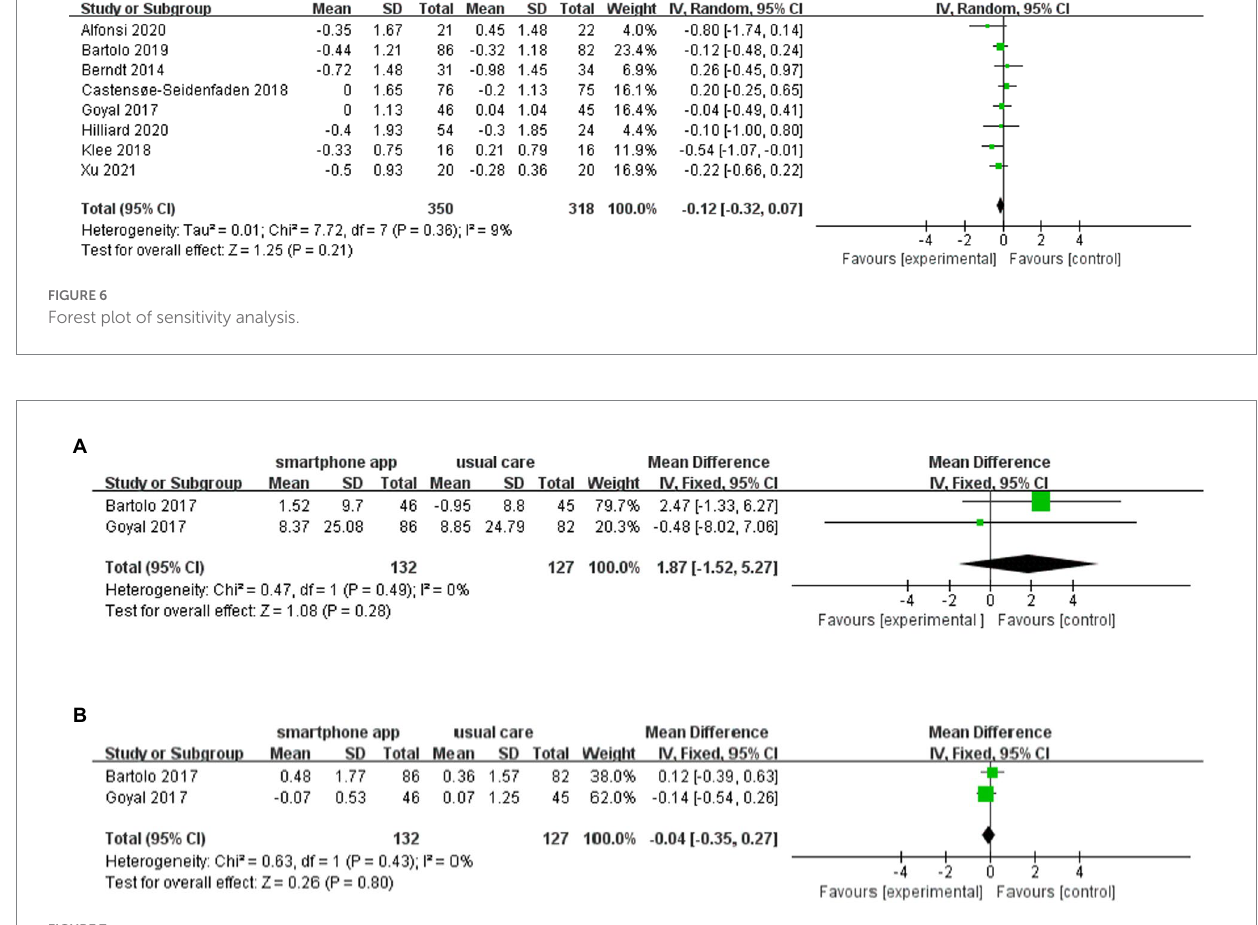
FIGURE 7 Forest plot of smartphone app intervention and incidence of (A) mild and (B) severe